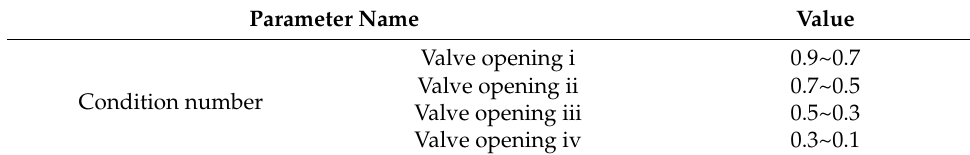
Table 8. Reversing valve spool stuck under different working conditions.